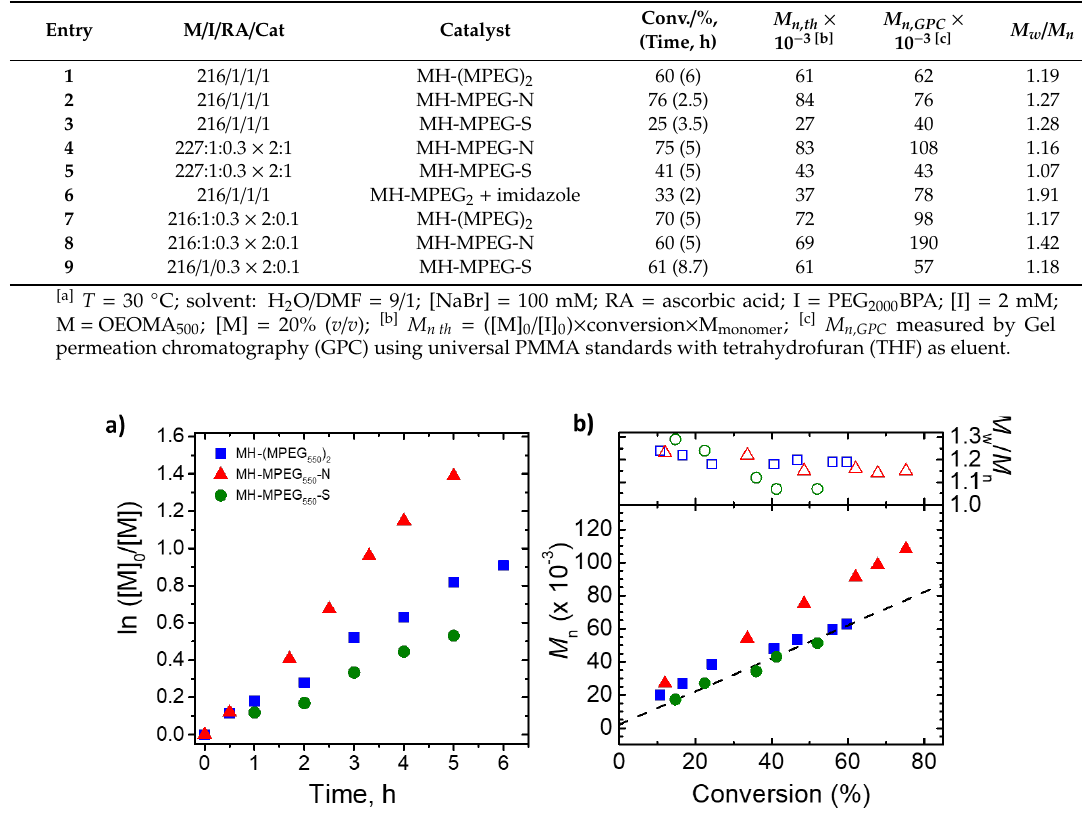
Figure 2. Cyclic voltammogram of ( a ) Mesohemin-methoxy poly(ethylene glycol) (MPEG) 550 -N and ( b ) Mesohemin-MPEG 550 -S, scan rate = 100 mV/s, supporting electrolyte = tetrabutylammonium hexafluorophosphate (TBAPF 6 , 0.1 M in DMF).